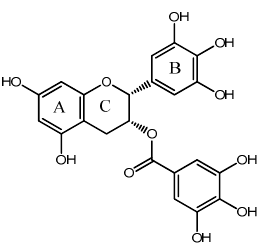
Figure 1. The chemical structure of EGCG.